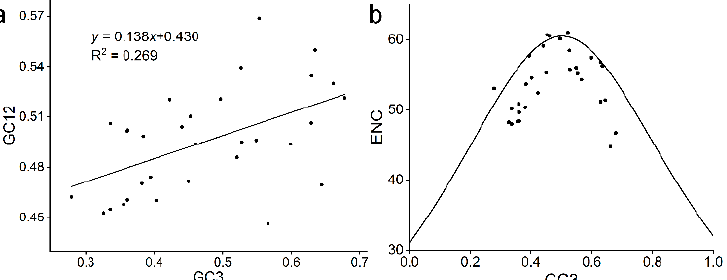
Figure 6. The correlation analysis of GC3, GC12, and ENC in A. nanus . ( a ) The correlation analysis of GC3 and GC12. ( b ) The correlation analysis of GC3 and ENC.